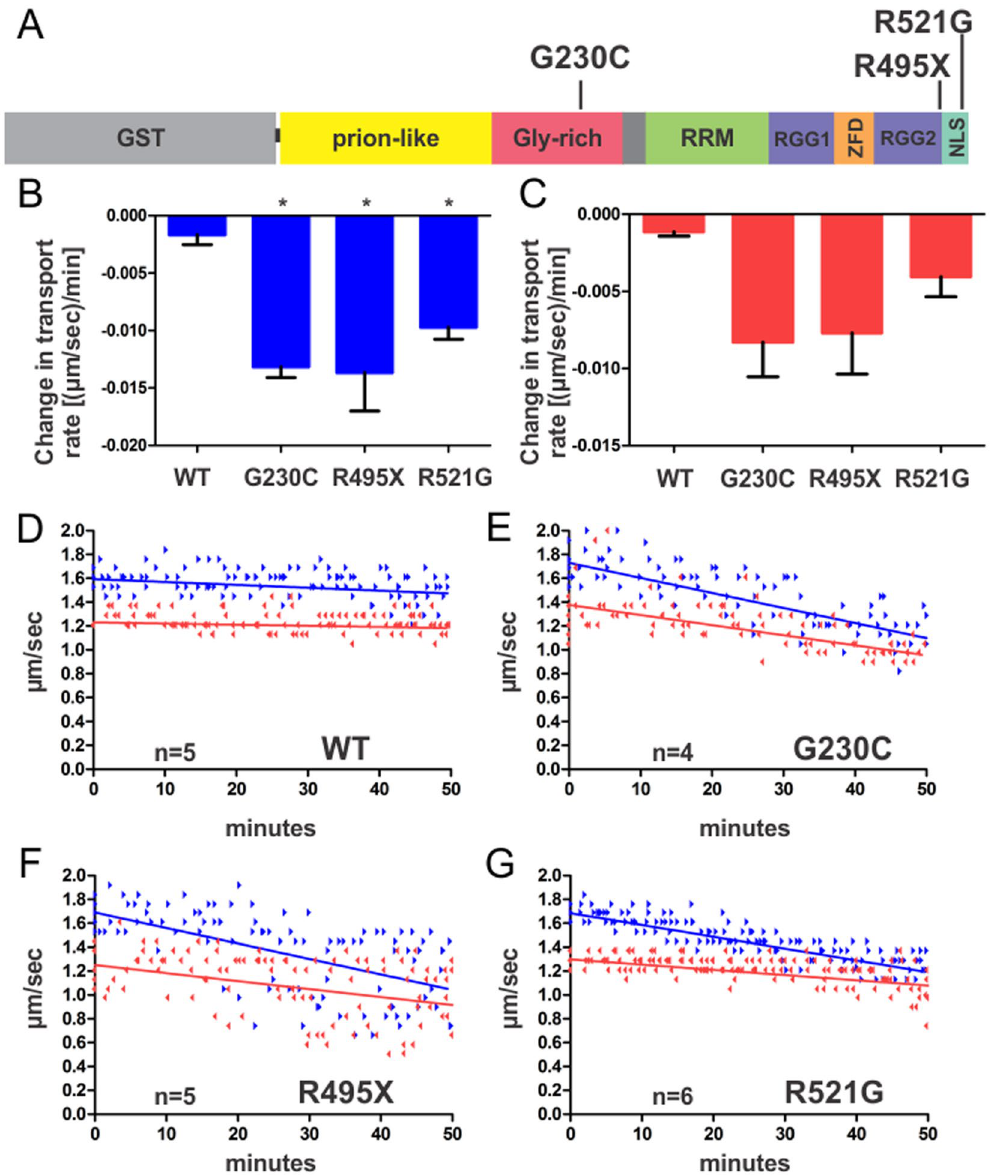
Figure 1. ALS-linked mutant FUS proteins impair anterograde and retrograde FAT. ( A ) ALS-linked mutations (G230C, R495X and R521G) investigated in this study are mapped onto the domain structure of GST-FUS. RRM = RNA recognition motif, RGG = arginine-glycine-glycine-rich, ZFD = zinc-finger domain and NLS = nuclear localization signal. ( B–G ) FUS proteins (2.5 μ M) were perfused into isolated squid axoplasm and fast axonal transport (FAT) rates ( μ m/s) of membrane bounded-organelles measured as a function of time (minutes). For ( B , C ), slopes of the linear best fits for velocities obtained for each axoplasm ( D–G ) were averaged and plotted as bar graphs in Graphpad Prism with the standard error of the mean (SEM) for anterograde (blue bars; A ) and retrograde (red bars; B ) velocities. Those conditions with statistical significance ( p < 0.05) relative to FUS WT are denoted by * , determined by one-way Anova and Tukey post-hoc test for multiple comparisons. ( D–G ) Motility plots comprised of the raw data for every axoplasm (‘n’ denotes the number of axoplasms analyzed for each condition) are shown, where linear best fits of the compiled data are shown for anterograde (blue arrowheads; linear fit shown as a solid blue line) and retrograde (red arrowheads; linear fit shown as a solid red line) directions. Protein obtained from at least two independent protein expression and purifications were included for each FUS